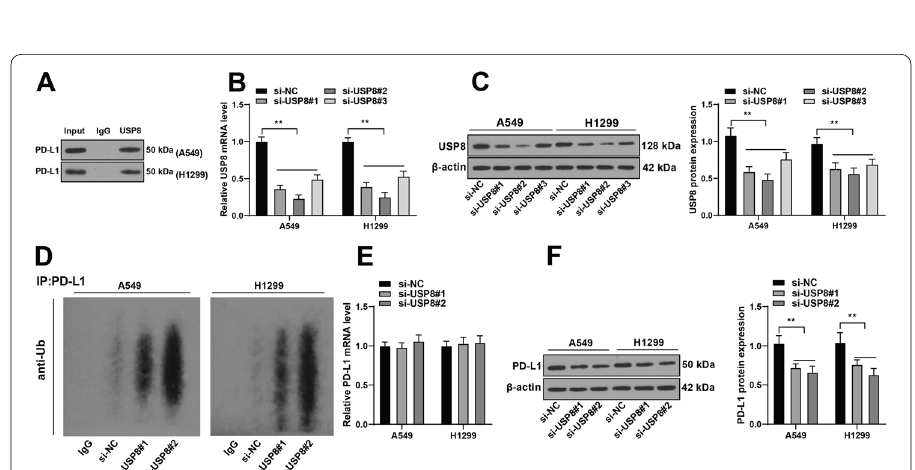
Fig. 6 USP8 stabilized the protein level of PD-L1 through deubiquitination. A The binding between PD-L1 and USP8 was analyzed via Co-IP assay; three strands of USP8 siRNA (si-USP8) were transfected into A549 or H1299 cells, with si-NC as the negative control; B , C USP8 expression in NSCLC cells was detected via RT-qPCR and western blotting; D ubiquitination level of PD-L1 in NSCLC cells was detected via Co-IP and western blotting; E , F PD-L1 expression in NSCLC cells was detected RT-qPCR and western blotting. Cell experiments were performed three times, ** P < 0.01. Data are represented as mean standard deviation. Multigroup ± comparisons in B , C , E , and F were analyzed using two-way ANOVA, followed by Tukey’s multiple comparison